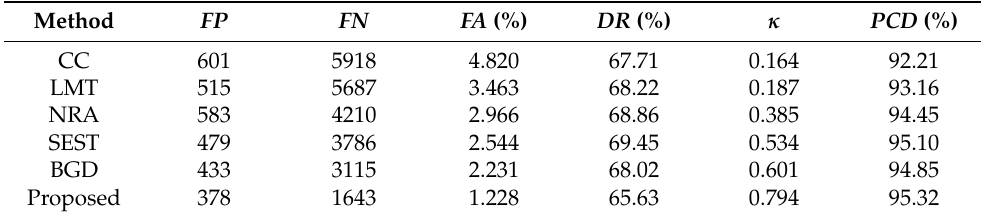
Table 1. Comparison of results from all the six methods using dataset 1 before median filtering.